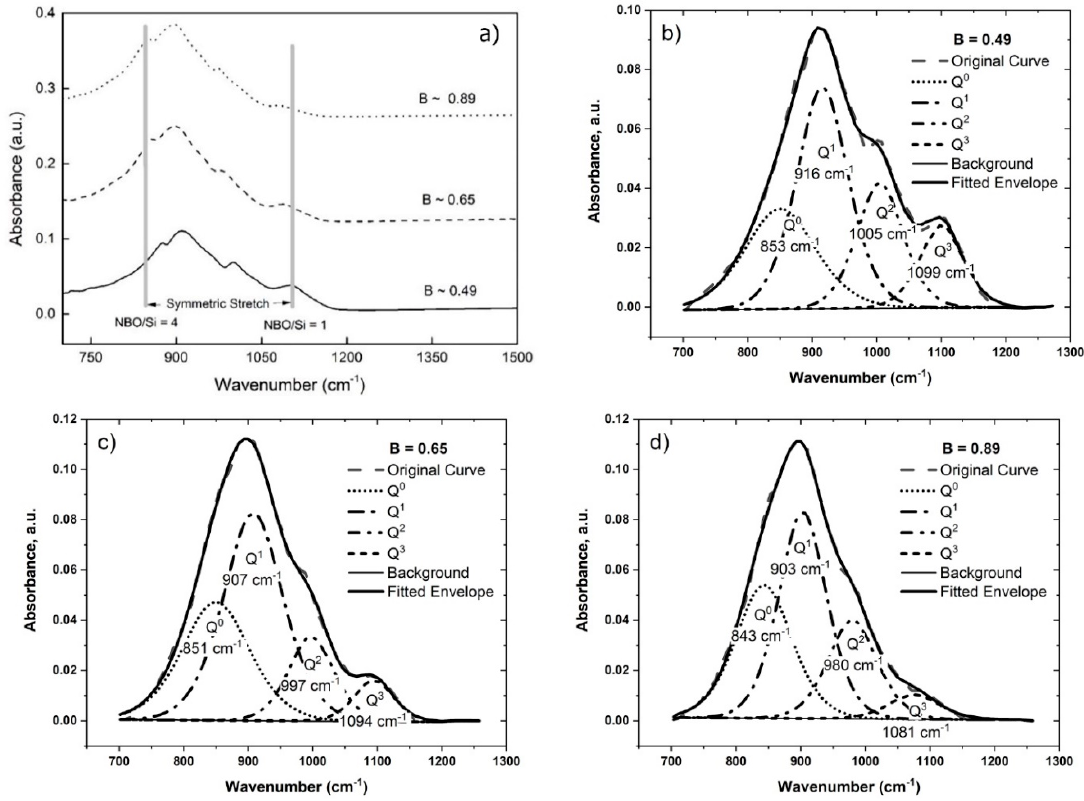
Figure 6. ( a ) FTIR spectra of FCSM slags of basicity 0.49 to 0.89 ( p O 2 = 10 − 8 atm and T = 1300 °C); and deconvolution results of FTIR spectra for slag with ( b ) basicity (B) = 0.49, ( c ) B = 0.65 and ( d ) B = 0.89.